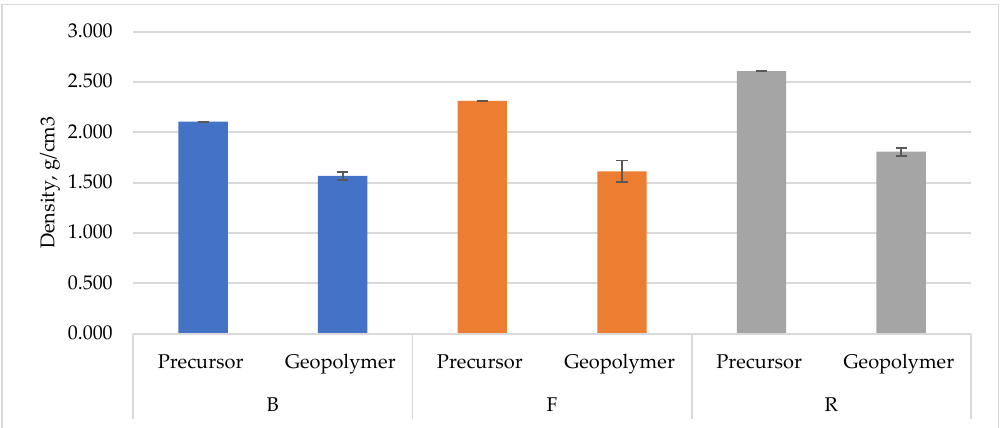
Figure 3. Density results of tested materials.